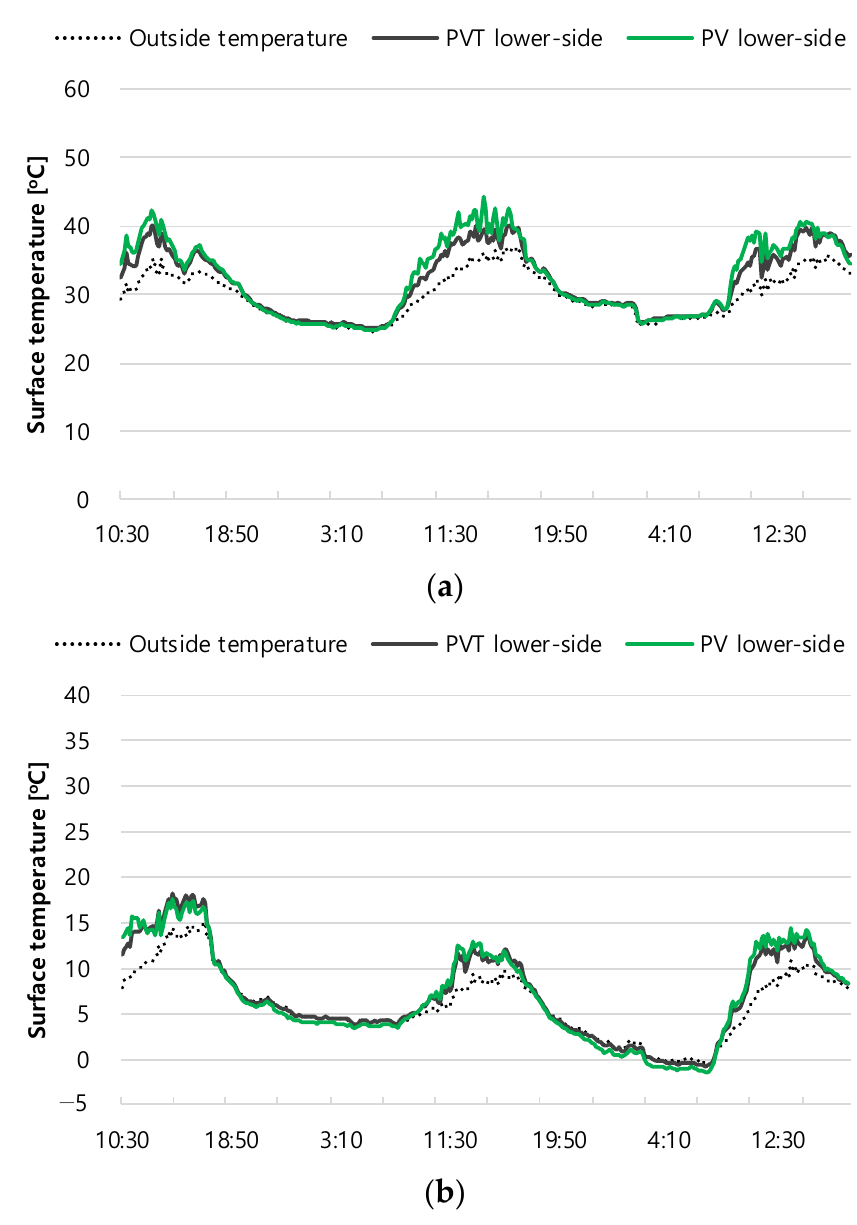
Figure 4. Lower surface temperature of the panels: ( a ) summer; ( b ) winter. Figure 7 shows the heat collection effect owing to the increase in the temperature of the air passing through the PVT panel. The volume of air generated by the fan applied in this experiment was 4.82 m 3 /min (the fan had a diameter of 9 cm and the average wind speed was 12.63 m/s). In the summer, the maximum and average heat collection amount calculated from the temperature difference between the inlet and outlet of the panel, the amount of air, and the specific heat of air were 684.4 W and 326.0 W, respectively; in the winter, these values were 486.5 W and 252.8 W. It was shown that the air passing through the bottom of the PVT panel can reduce the surface temperature, increase the amount of power generated, and help collect additional thermal